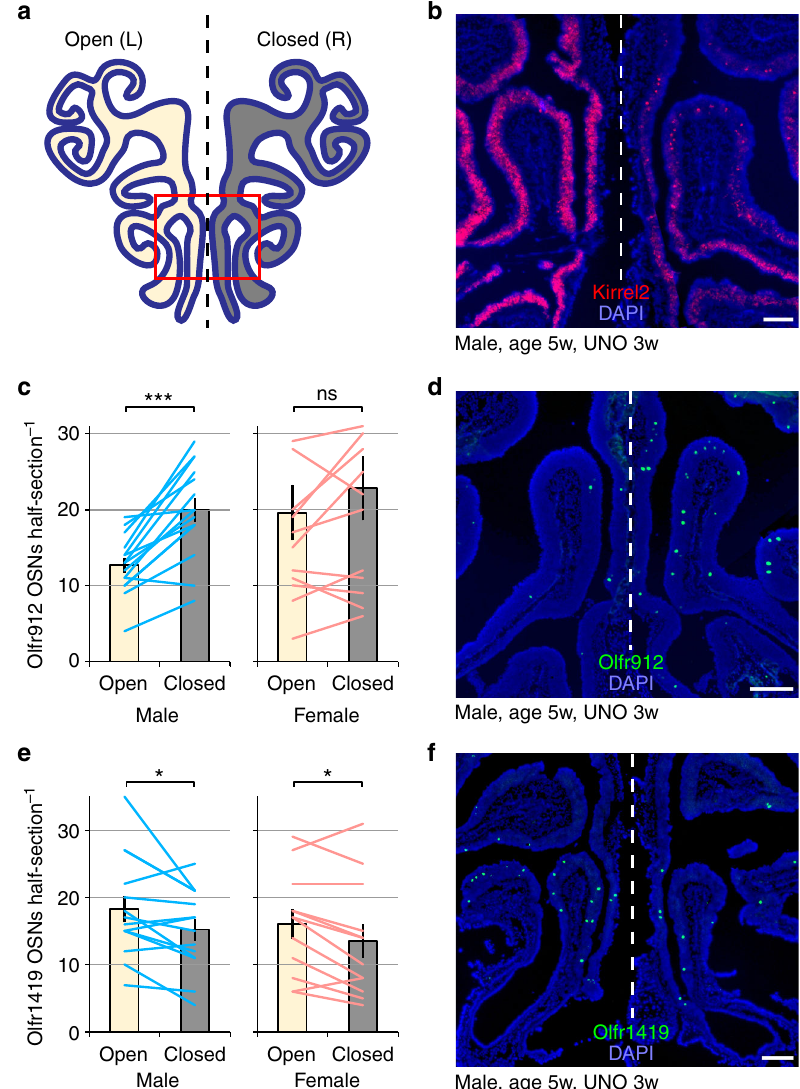
Fig. 6 Olfactory deprivation via unilateral naris occlusion (UNO) alters the expression frequency of SF-biased and SM-biased ORs. a Schematic of a coronal MOE section following occlusion of the right nostril. The red box corresponds to the approximate region of the images shown in b , d , and f . b Con fi rmation of UNO ef fi ciency via RNA-FISH analysis of the expression of Kirrel2 5,8 , an activity-dependent gene that is more strongly expressed on the open (left) side of the MOE. c , e Quantitation of Olfr912 -expressing ( c ) and Olfr1419 -expressing ( e ) OSNs on the open and closed sides of the MOEs of mice subjected to UNO. Each line represents a different MOE section. Error bars: s.e.m. * p < 0.05, *** p < 0.001 (two-tailed paired t test); n = 12 male and 16 female sections (taken from 4 mice of each sex). d , f Representative images of Olfr912 ( d ) and Olfr1419 ( f ) expression in the MOEs of mice subjected to occlusion of the right nostril. Scale bars: 200 µ